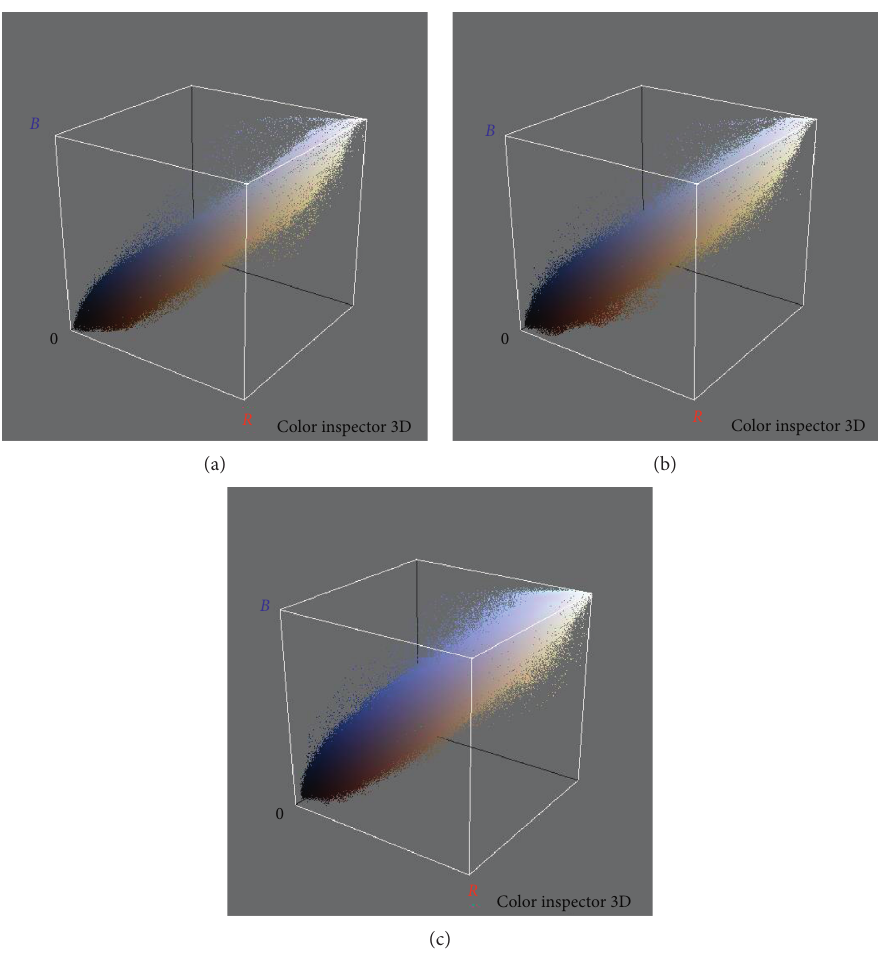
Figure 5: RGB-model of (a) Dry-WP170, (b) 1FT-WO170, (c) 3FT-WP170.